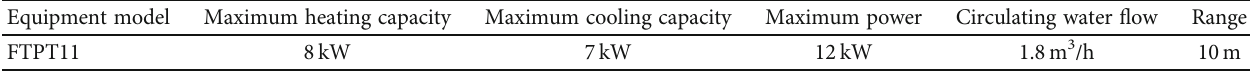
Figure 6: Main machine (a) and refrigeration auxiliary machine (b). Table 1: Performance parameters of test